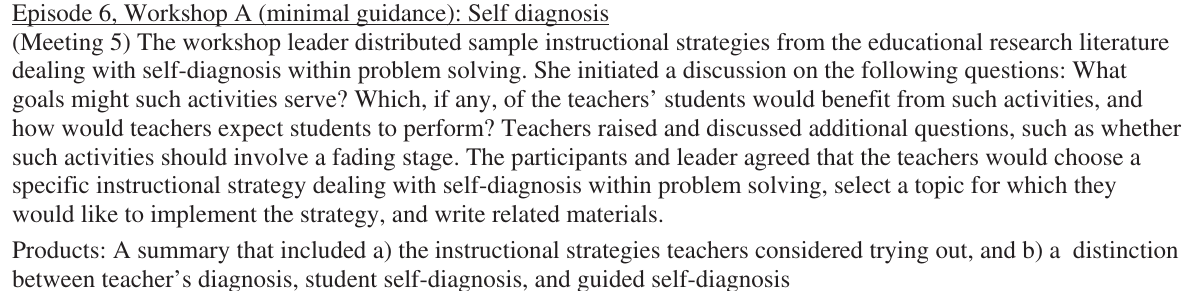
FIG. 1. Example of an episode description.